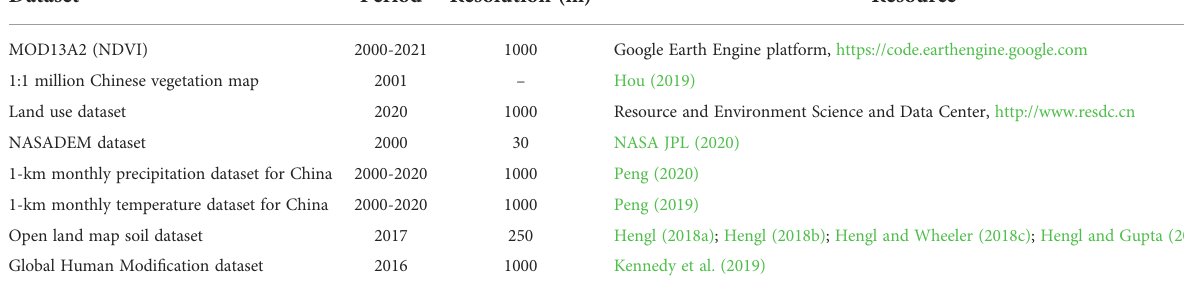
TABLE 1 Datasets resources in this